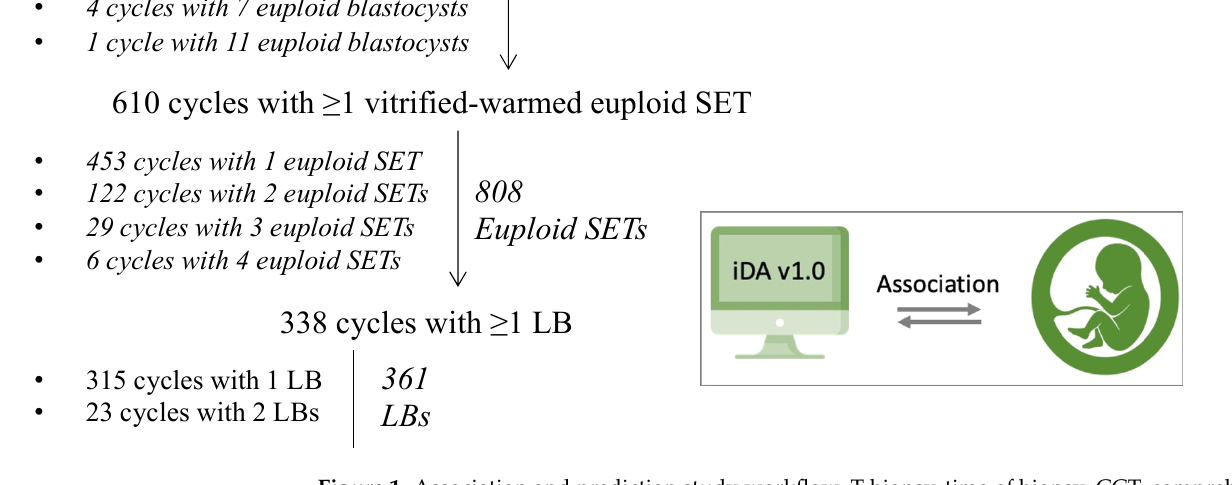
Figure 1. Association and prediction study workflow. T-biopsy, time of biopsy; CCT, comprehensive chromosome testing; iDA v1.0, Intelligent Data Analysis score version 1.0; SETs, single embryo transfers; LBs, live births.